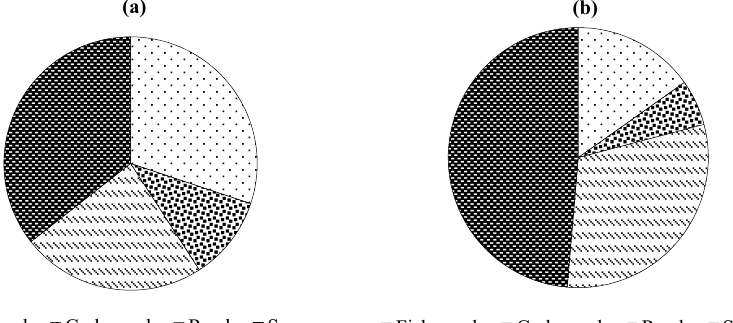
Figure 3. Proportion of ecological benefits for fish ponds, crab ponds, reed fields, and swamp wetlands: ( a ) before optimization; and ( b ) after optimization.